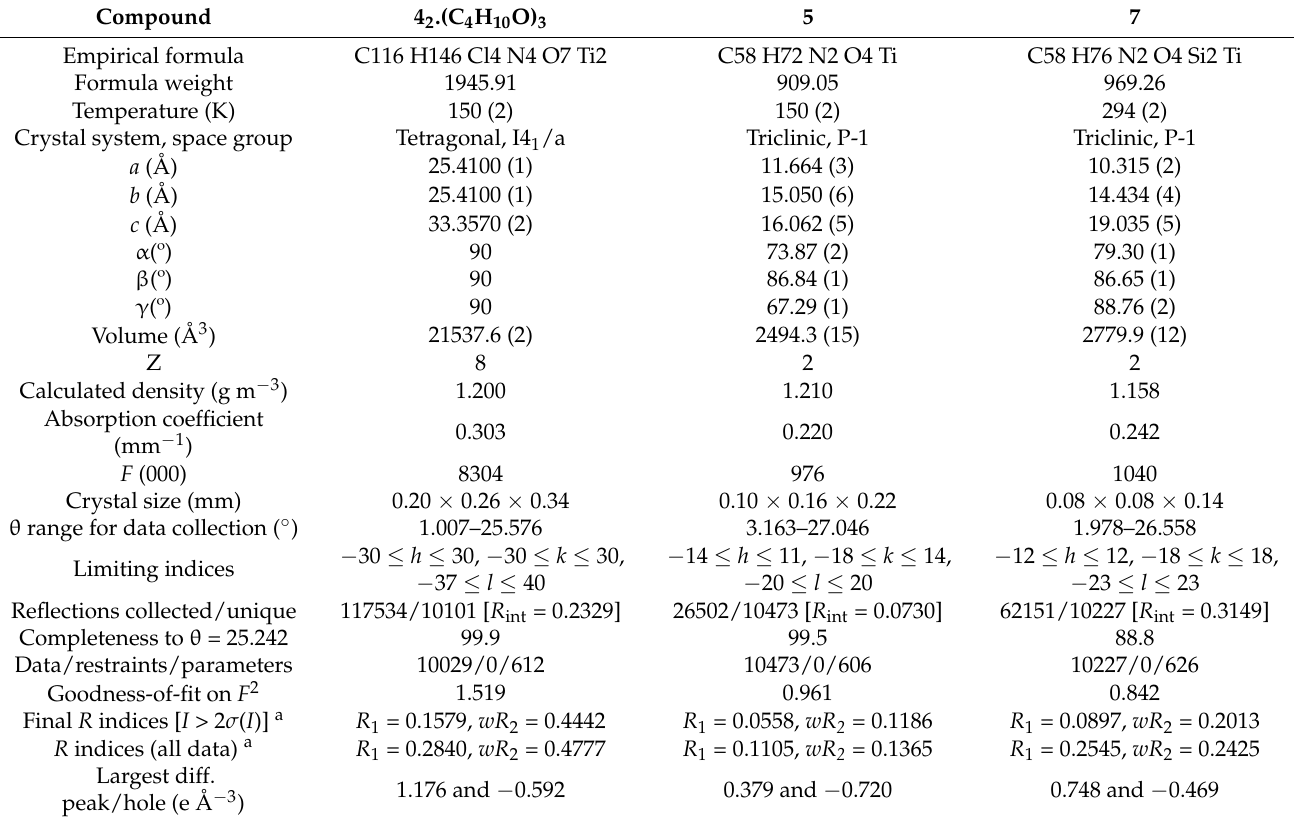
Table 3. Crystal data and structure refinement for complexes 4 , 5 , and 7 .